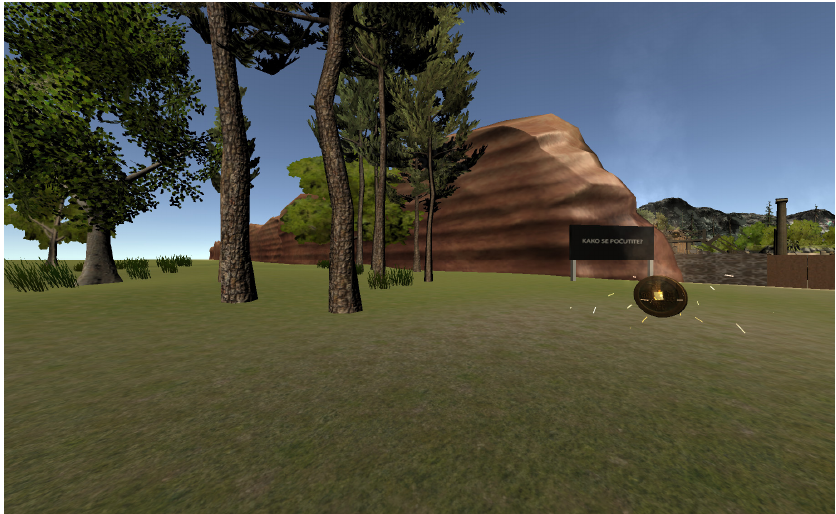
Figure 2. A forest scene from the low action game mode without head-centric rest-frames. On the figure, there is a visible golden coin, which is set on the player’s height. To collect the coin, the players needed to pass through it, which made the coin disappear. In the background, there is visible the big billboard, which was used to notify the players to give the FMS score. On the right part of the picture are visible doors, which was needed to be opened to proceed to the next scene of the game.